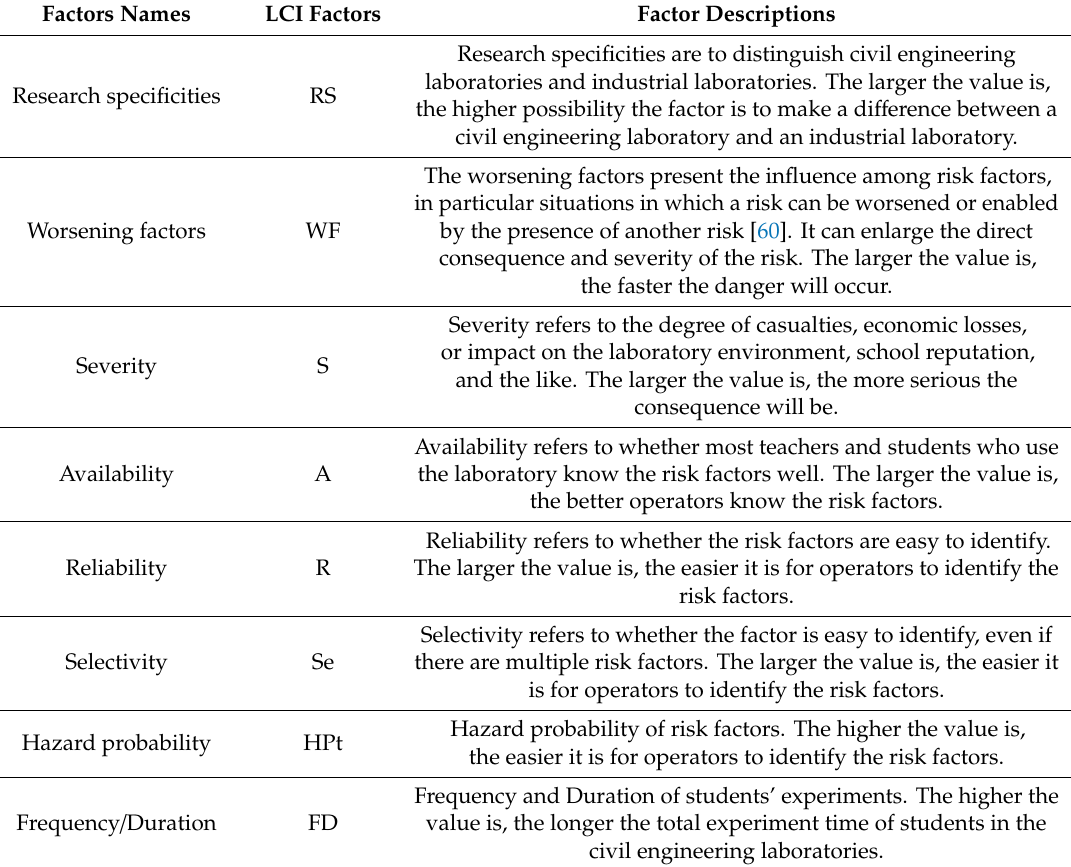
Table 3. Explanations of lab criticity index (LCI) contributing